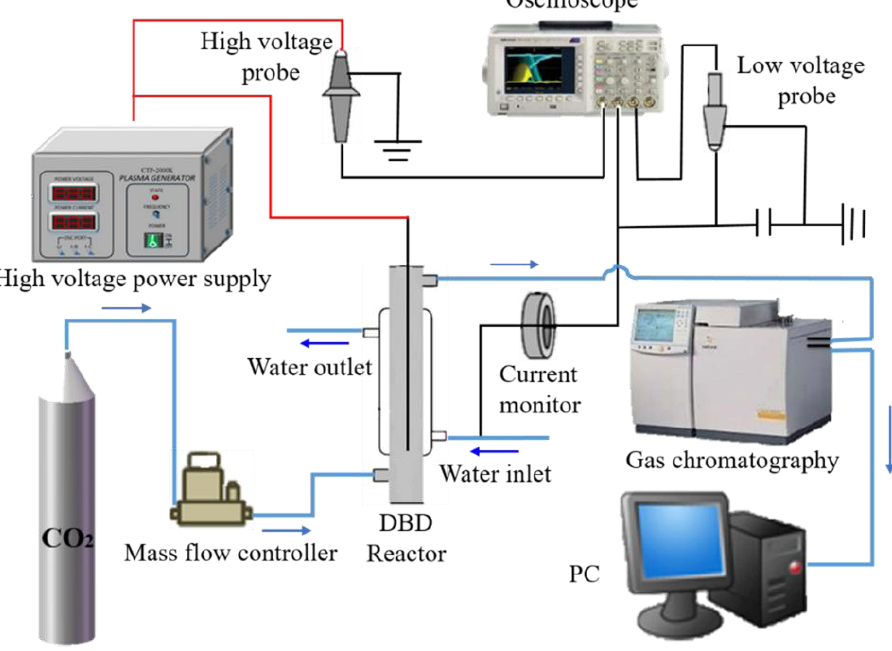
Figure 1. Schematic diagram of the experimental device for CO 2 splitting.